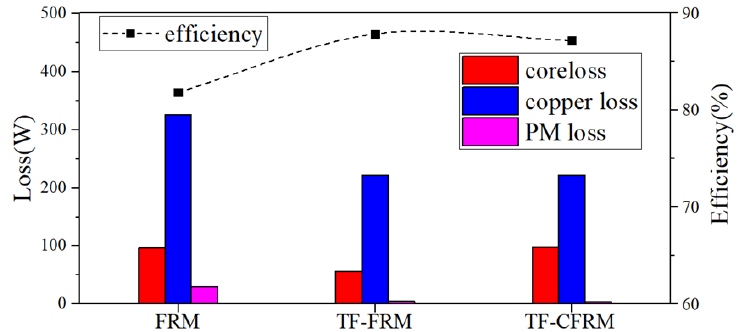
Figure 13. Loss distributions and efficiencies of FRM, TF-FRM, and TF-CFRM.